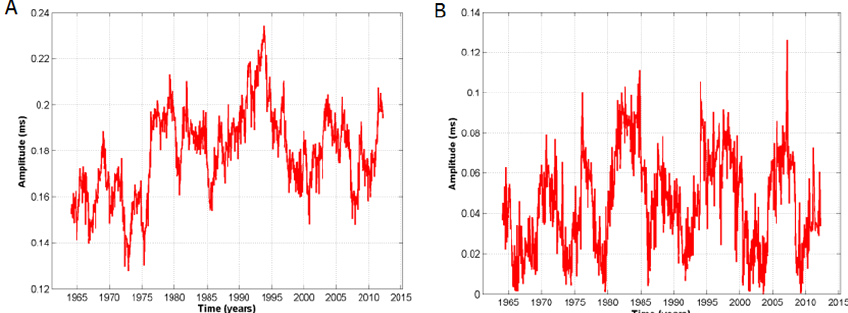
Figure 2. Oscillations of the LOD data set with different periods: 1 year (A) and 2 years (B) . FFT-window width remains unchanged at 4